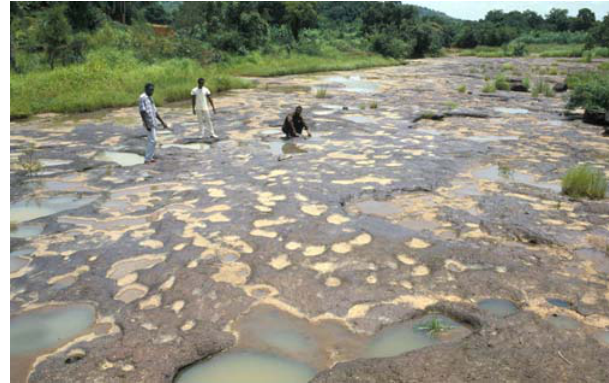
Figure 1. Rock pools along the Niger River, typical breeding sites of the An.gambiaeBamako chromosomal form. Courtesy of M. Fodde and M. Coluzzi.